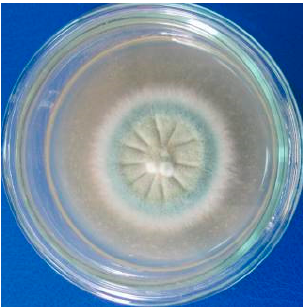
Figure 1. Appearance of M30 strain’s colonies.